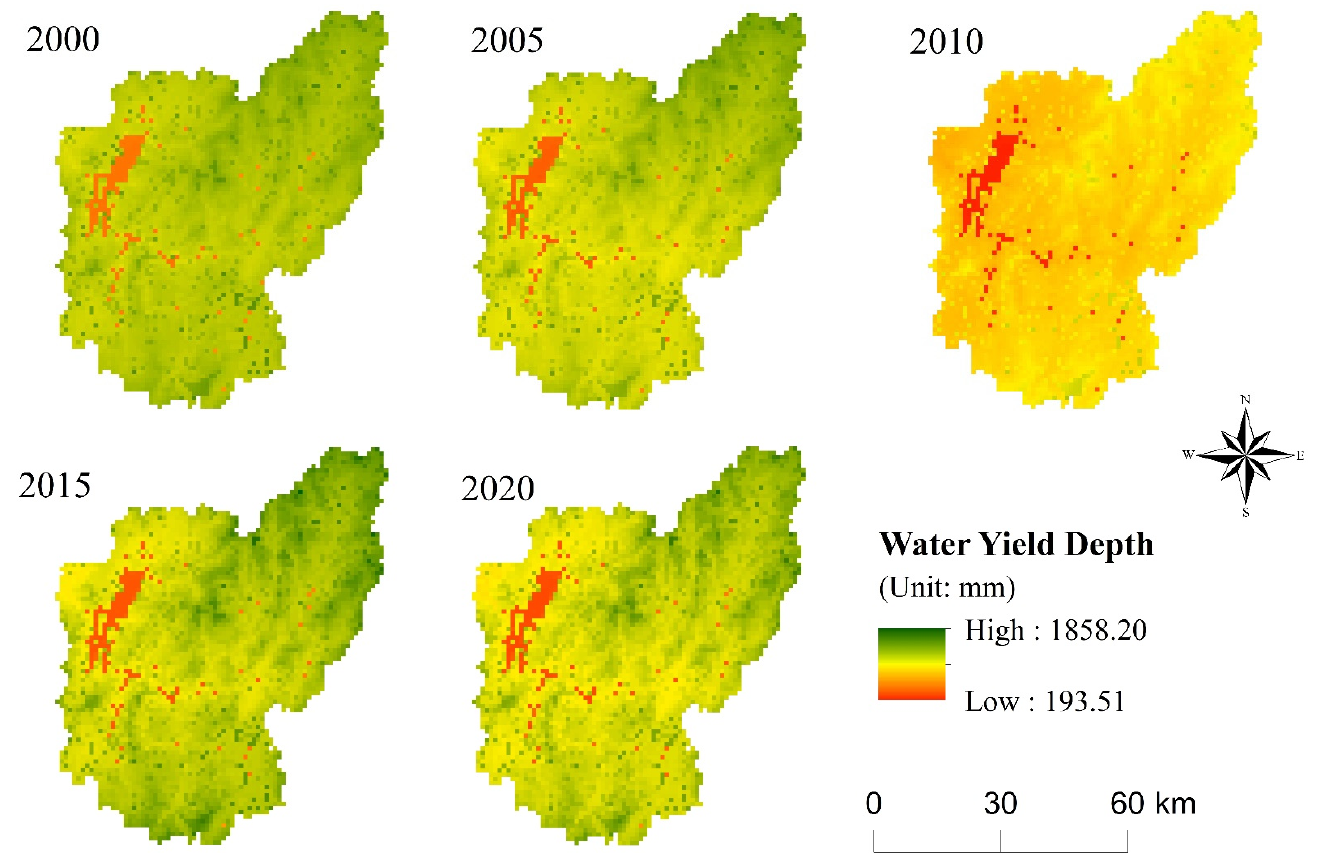
Figure 4. Spatial distribution of water yield in the Dongjiang River Basin.